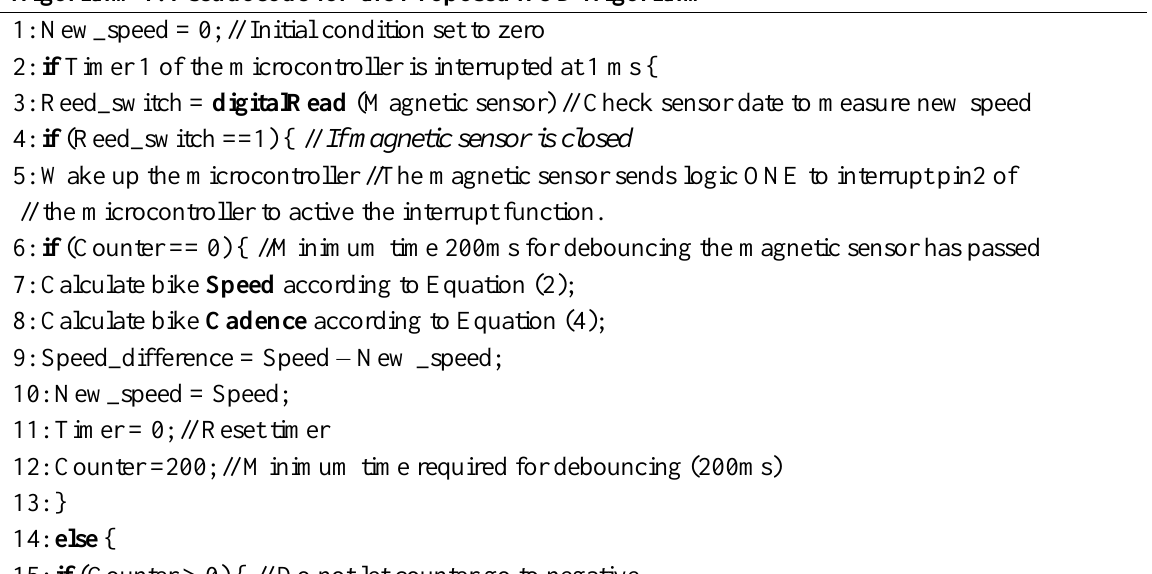
Algorithm 1: Pseudocode for the Proposed RCD